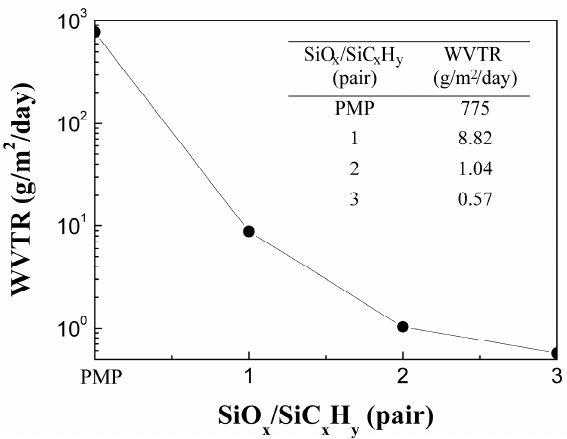
Figure 2. Water vapor transmission rate for the PMP without and with one-, two-, and three-pair SiO x /SiC x H y layers at 40 °C/100% relative humidity (RH).